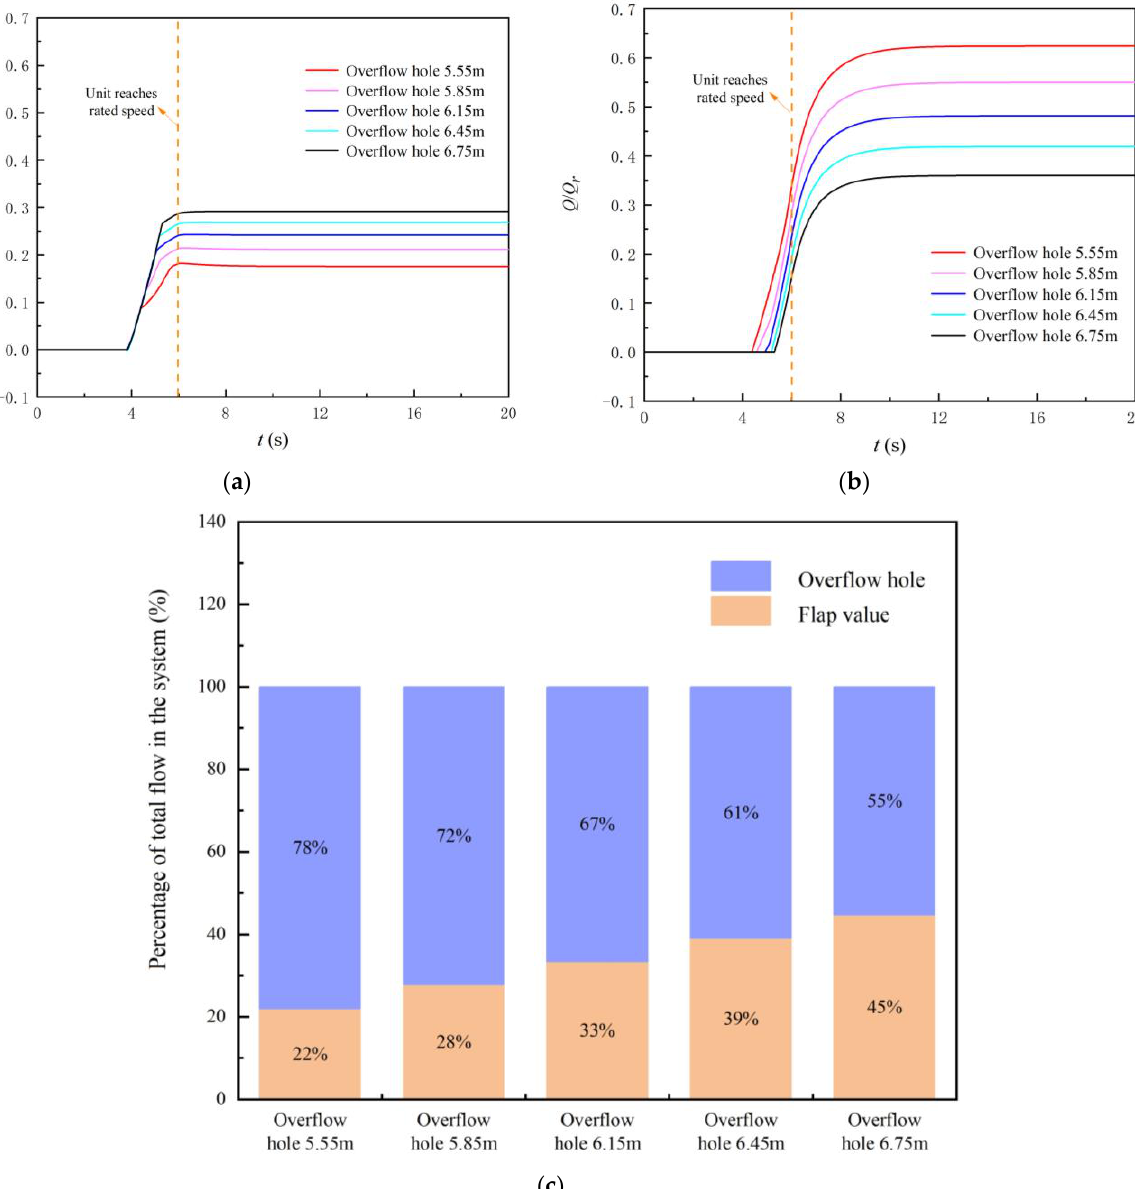
Figure 18. Variation in outflow from safety auxiliary facilities in the case of restricted FLVA settings. ( a ) FLVA. ( b ) OVHO. ( c ) Flow at FLVA and OVHO after start-up is complete.